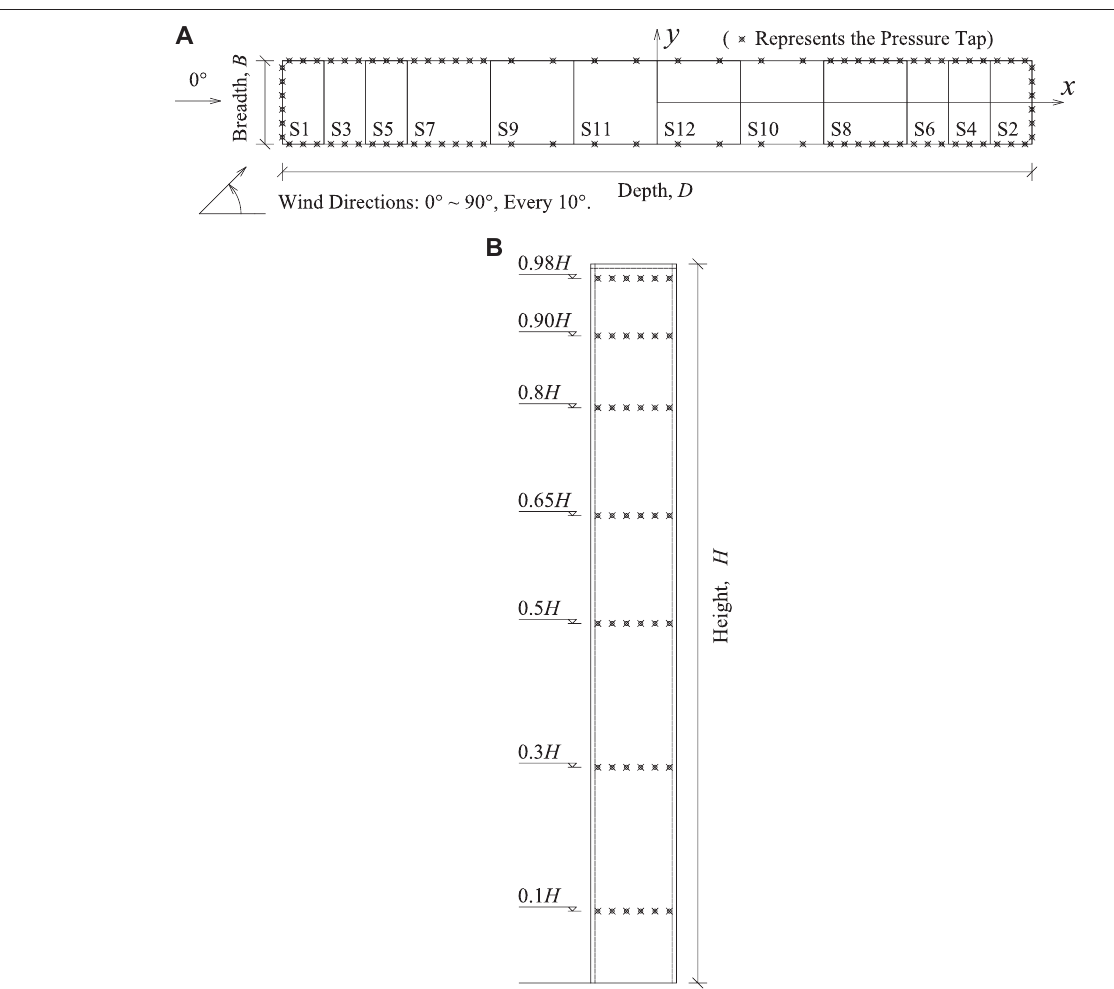
Frontiers in Built Environment |